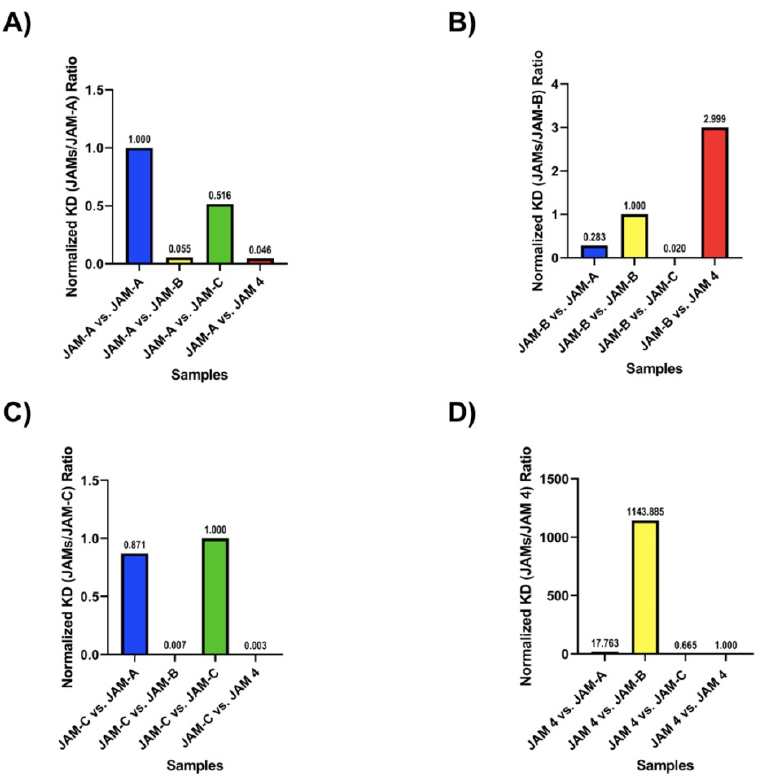
Figure 4. Surface plasmon resonance characterization of heterotypic interactions of JAMs. Heterotypic interactions of JAMs were determined by SPR (see Section 3 and Table 1). We studied the affinity of each JAM protein for all other members of the family. For each JAM analyzed, we normalized affinity (K D ) by that of the homotypic interaction of said JAM. The Y-axis represents the normalized affinity, heterotypic JAM/homotypic JAM, as a ration. The X-axis describes the homotypic interactions tested. ( A ) Heterotypic interactions of JAM-A, normalized to K D of JAM-A vs. JAM-A. ( B ) Heterotypic interactions of JAM-B, normalized to K D of JAM-B vs. JAM-B. ( C ) Heterotypic interactions of JAM-C, normalized to K D of JAM-C vs. JAM-C. ( D ) Heterotypic interactions of JAM4, normalized to K D of JAM4 vs. JAM4.